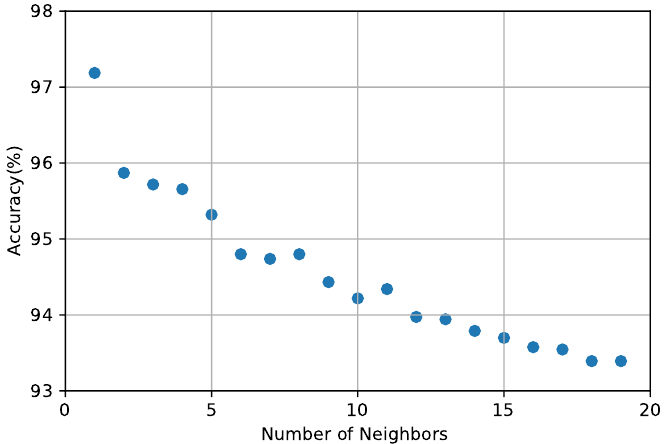
Figure 5. Accuracy according to number of neighbors for k -nearest neighbors (KNN)